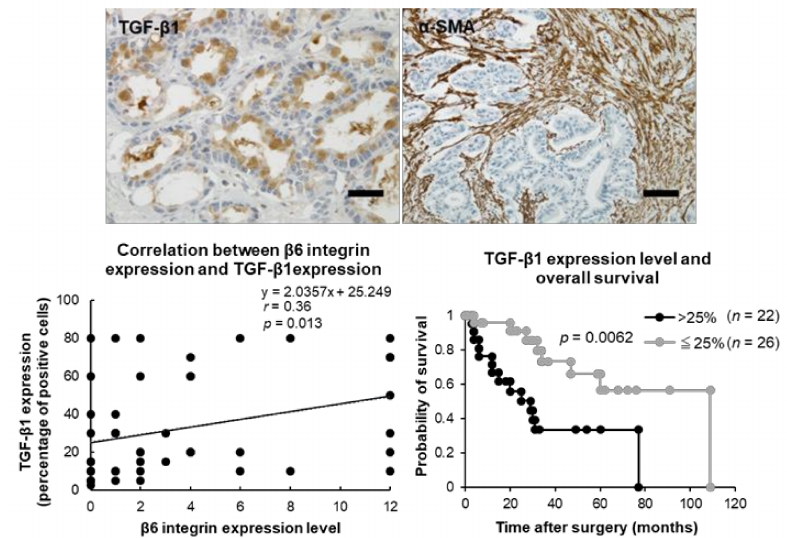
Figure 5. Expressions of transforming growth factor (TGF)- β 1 and α -smooth muscle actin (SMA) in intrahepatic cholangiocarcinoma. TGF- β 1 is shown in the cytoplasm of tumor cells, while α -SMA is shown in the stroma of intrahepatic cholangiocarcinoma. TGF- β 1 expression is correlated with β 6 integrin expression levels and overall survival rate. Scale bar, 50 µ